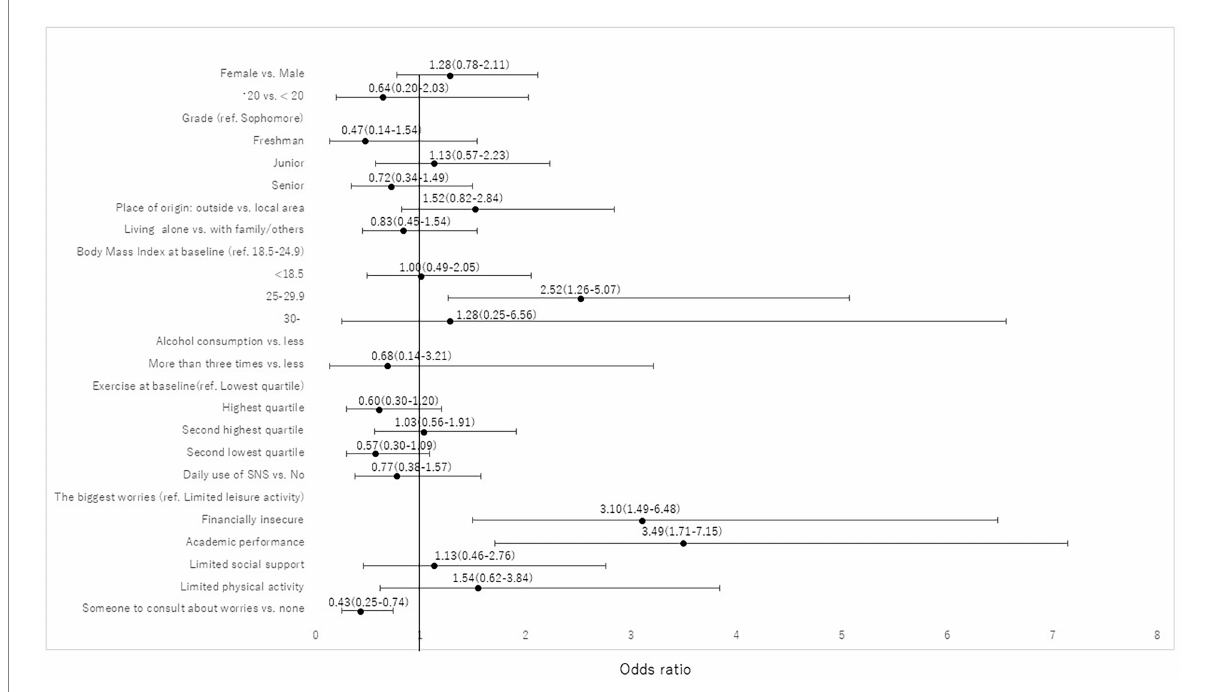
FIGURE 2 Factors associated with new onset of moderate depression based on PHQ-9 score ≥ 10 at T 2. The multivariate model demonstrated that being overweight (OR, 2.52, 95% CI, 1.26–5.07), financial insecurity (OR, 3.10, 95% CI, 1.49–6.48) and academic performance (OR, 3.49, 95% CI, 1.71–7.15) were the biggest worries and risk factors, while the presence of someone to consult with about worries (OR 0.43, 95% CI, 0.25–0.74) was a coping